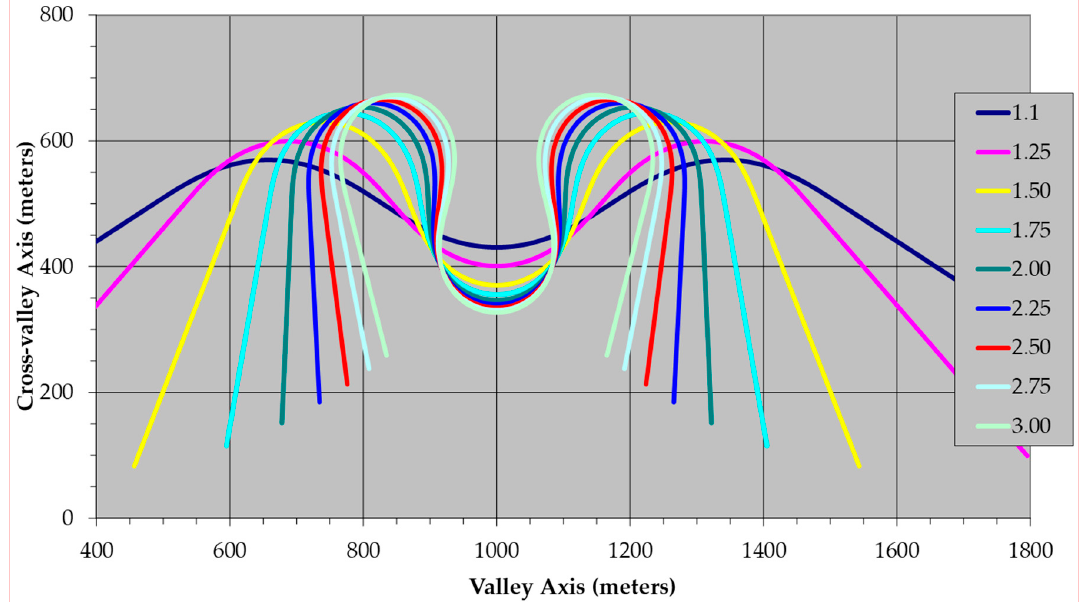
Figure 6. A series of meandering channel alignments (from Simulation Set 6, with three consecutive bends) are compared for a range of sinuosity from 1.1 to 3.0.